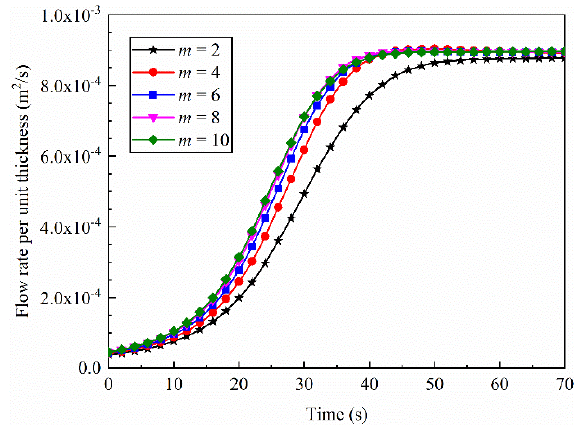
Figure 18. The flow rate per unit thickness curves for different homogeneity coefficients.